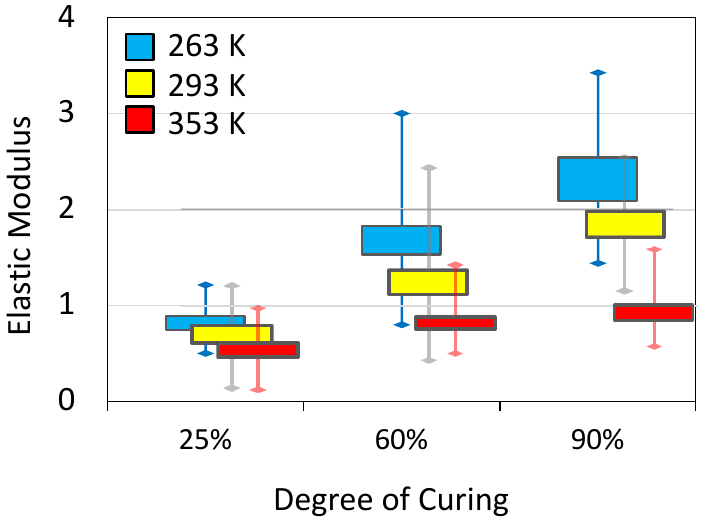
Figure 5. Box plots showing the dependence of Young’s modulus on the degree of crosslinking and temperature.